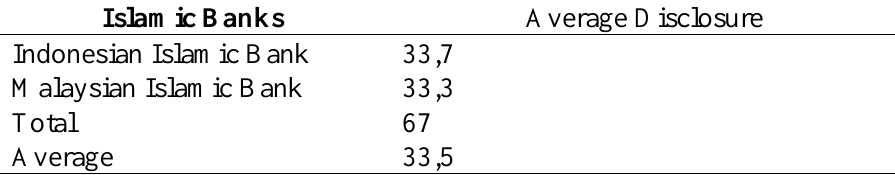
Table 6 Average Comparison of GCG Disclosure Annual